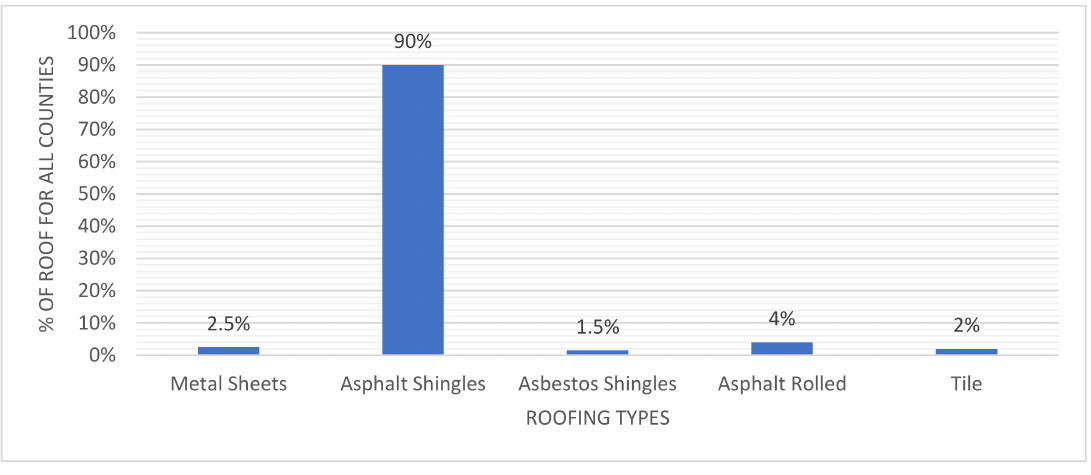
Figure 3. Type of roof materials.